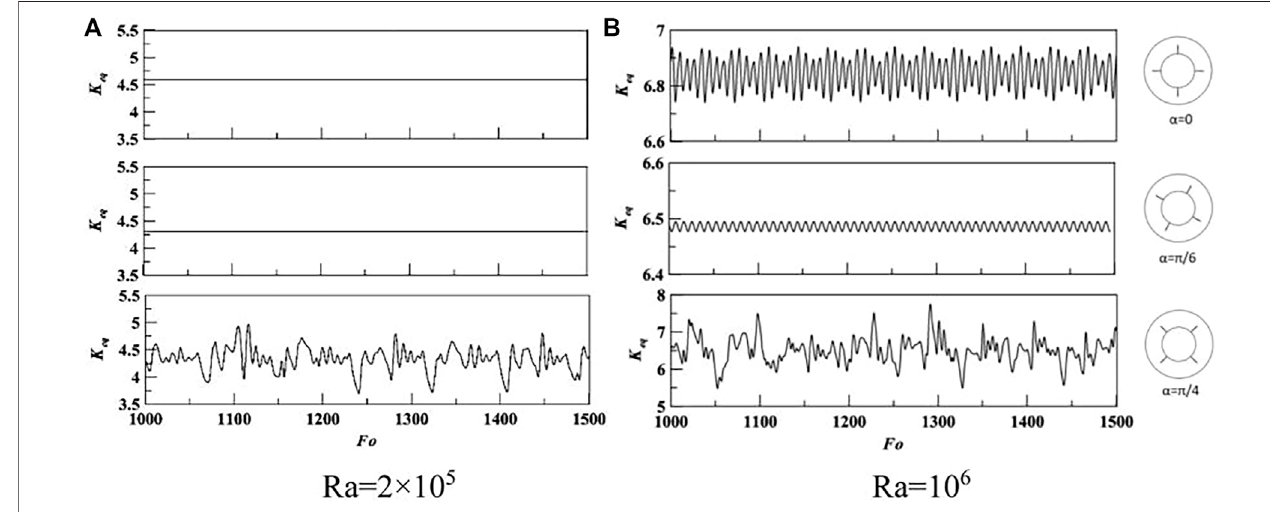
FIGURE 11 | Time signal of K eq for four fi ns with different positions. (A) Ra (cid:1) 2 × 10 5 (B) Ra (cid:1) 10 6 .